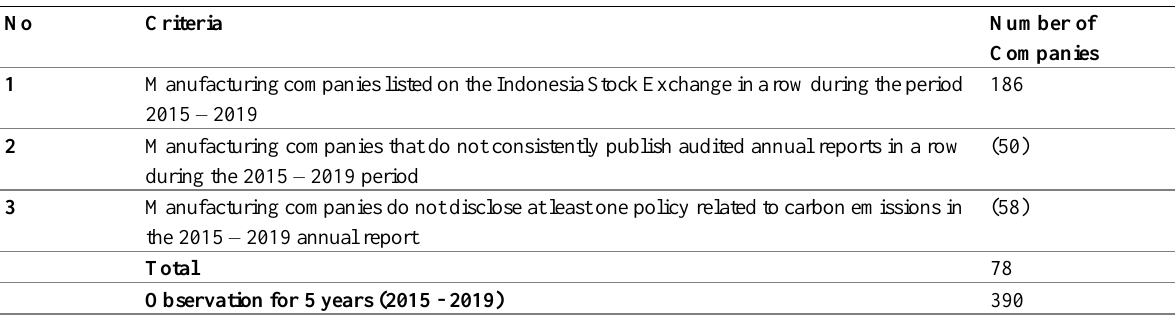
Table 1: Research Sample Results